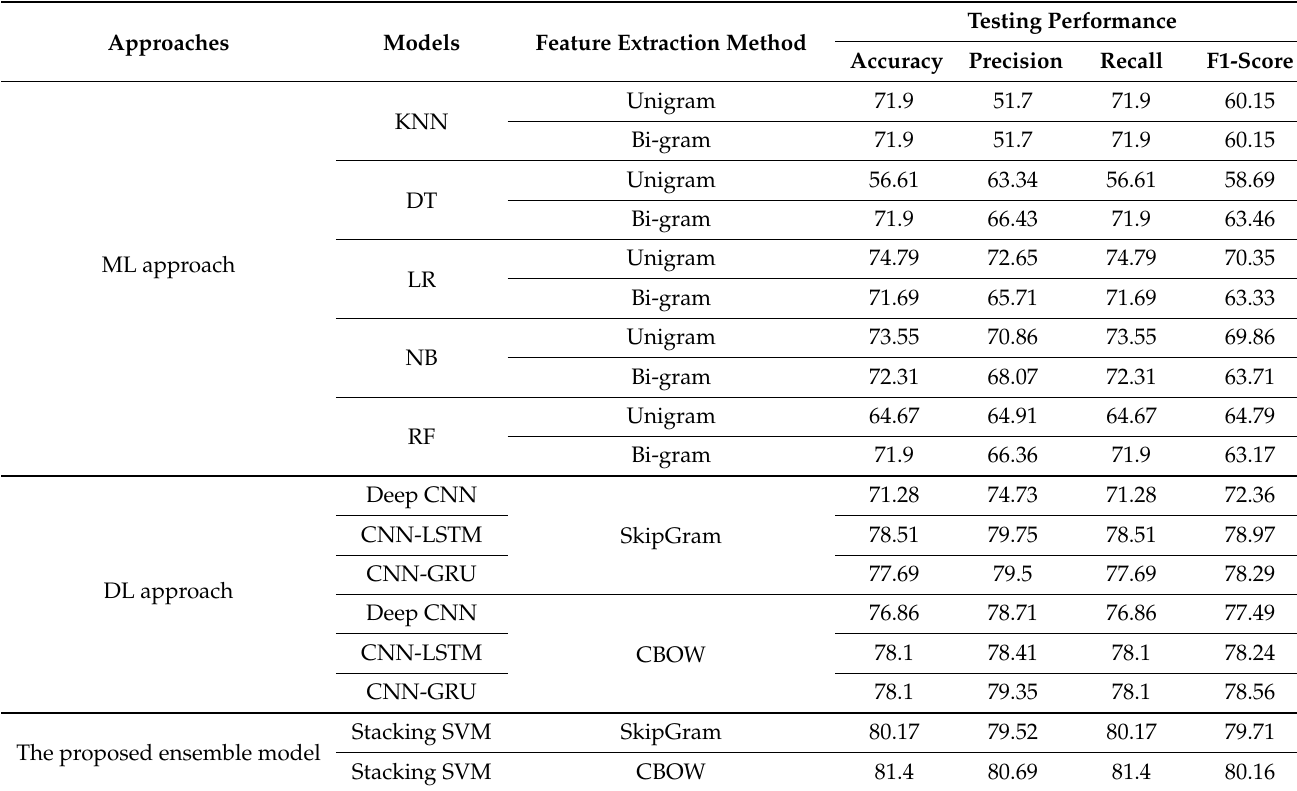
Table 6. The performance results of models for the ASTD